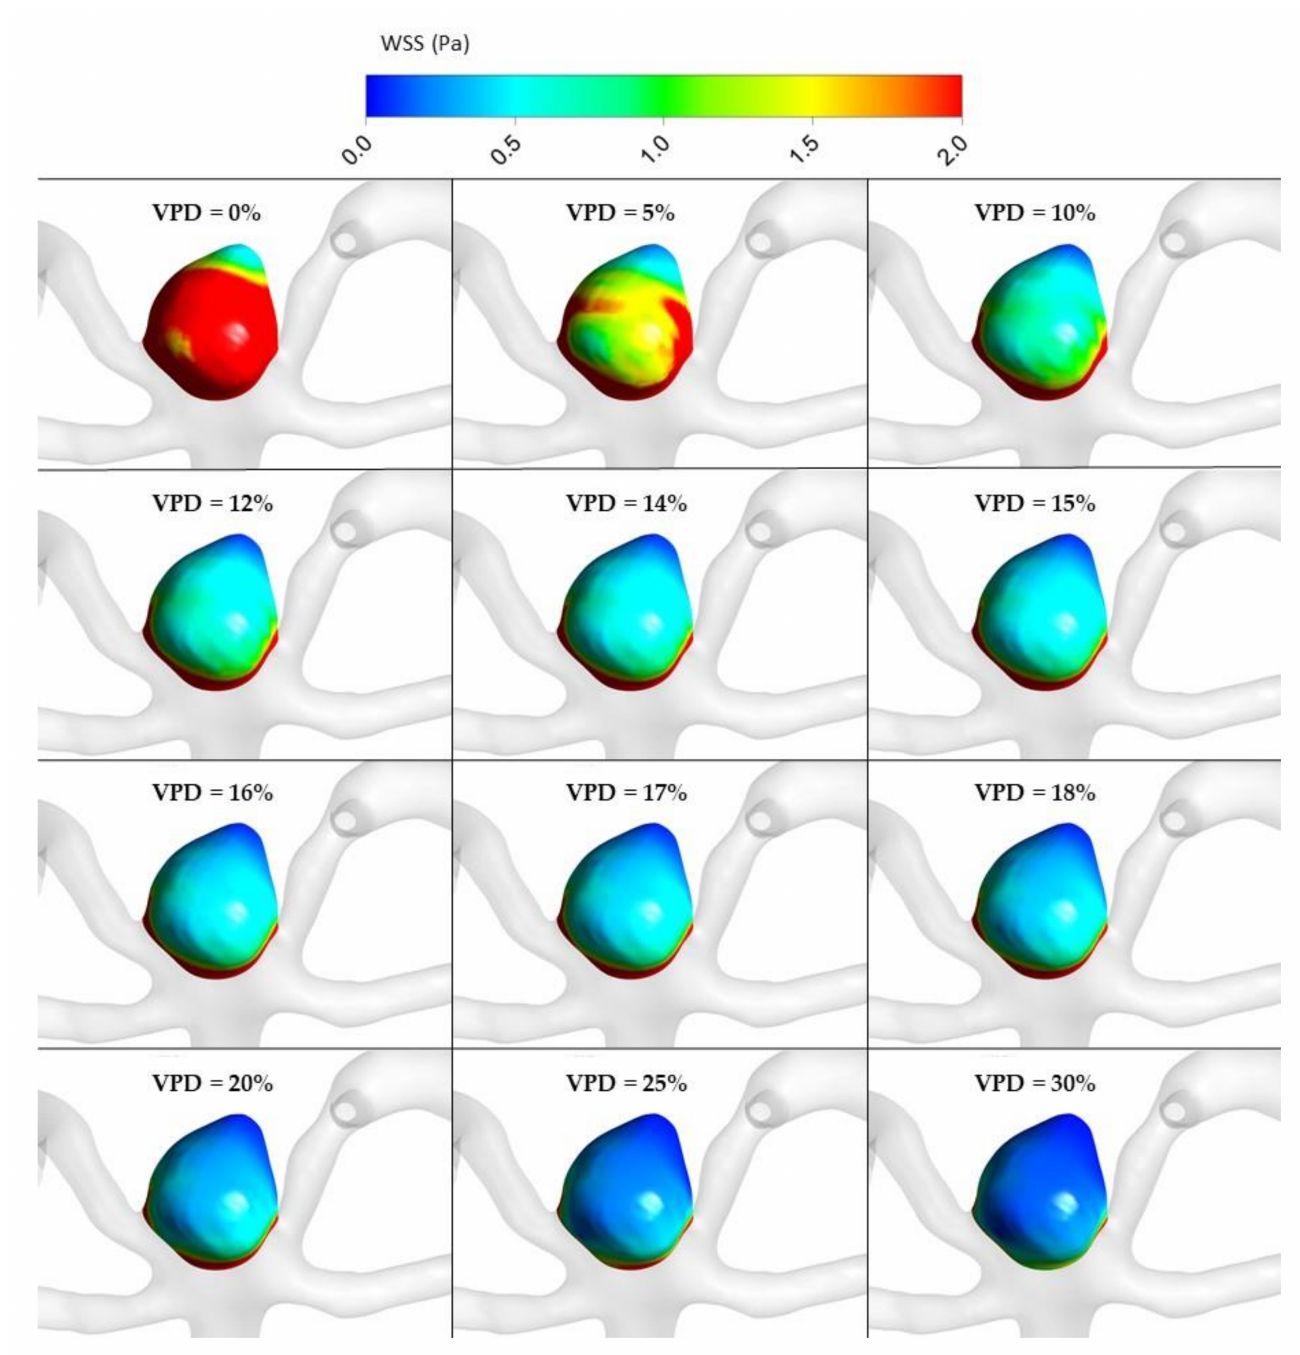
Figure 11. WSS distribution at aneurysm wall for selected VPD cases; stationary